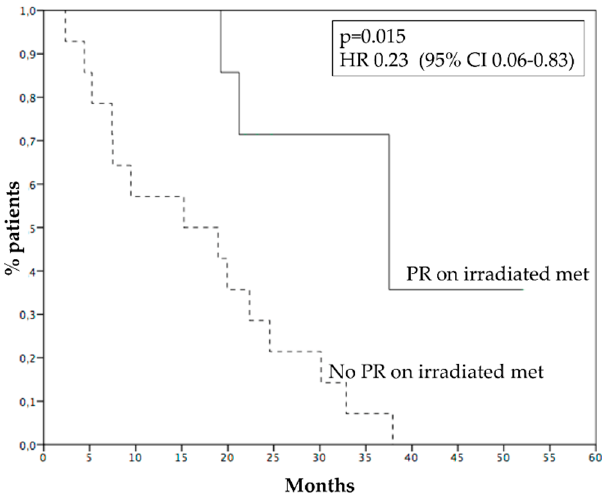
Figure 5. Survival of patients achieving a partial response of irradiate metastases (37.5 months, solid line) or not (15.2 months, dashed line).